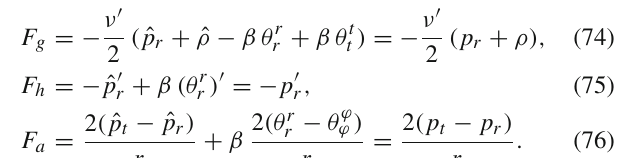
Fig. 6 The trend of the different forces versus the radial coordinate r / R . Top left and top right figures for 4U 1538-52 and SAX J1808.4- 3658, respectively while bottom left and bottom figures represent corre- sponding to compact objects for SMC X-1, and LMC X-4. For plotting of the above figures, we have chosen the same values of free parameters as used in Fig.